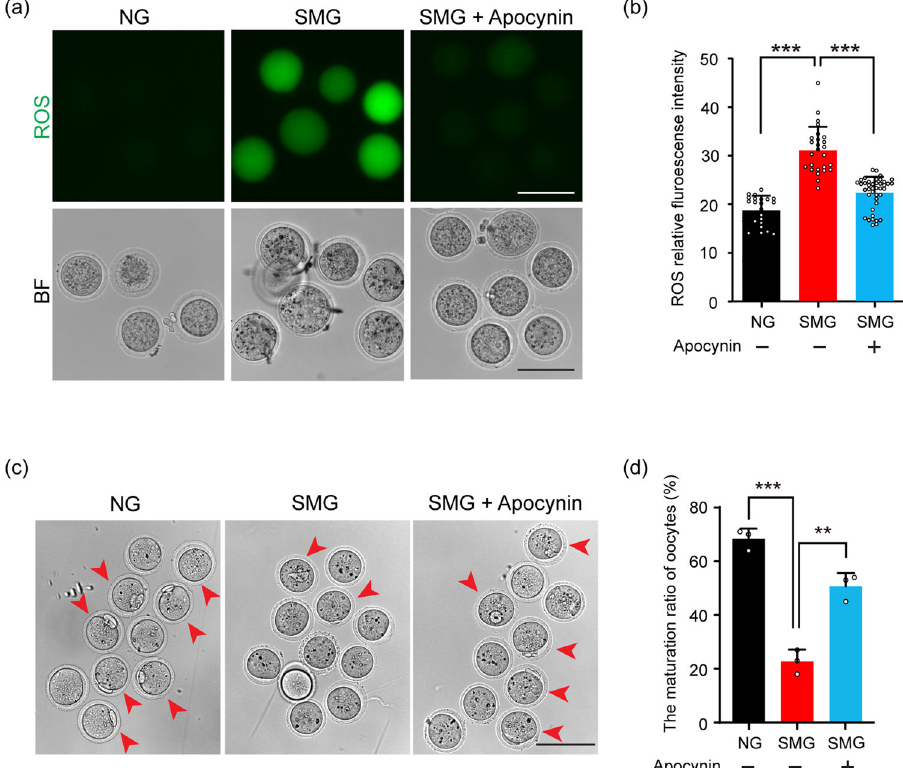
Fig. 6 Apocynin rescued SMG-related oocyte damage by decreasing the ROS level. a After follicle culturing with Apocynin under SMG condition, the follicle-released oocytes showed a dramatically decreased ROS level compared to the oocytes without Apocynin. Scale bars, 100 μ m. b The statistical analysis of DCF fl uorescence intensity, showing a decreased ROS level in oocytes of the Apocynin group ( n = 22 in NG, n = 26 in SMG and n = 41 in SMG + Apocynin). NG v.s. SMG: p value = 0.00000000000010, SMG v.s. SMG + Apocynin: p value = 0.000000028. c The ratio of PB1 (arrowheads) was markedly increased in the Apocynin-treated group compared to that in the SMG group. Scale bars, 100 μ m. d Statistic analysis showing a signi fi cantly increased ratio of PB1 in the SMG + Apocynin group compared to that in the SMG group ( n = 38 in NG, n = 35 in SMG and n = 43 in SMG + Apocynin). NG vs SMG: p value = 0.00021, SMG vs SMG + Apocynin: p value = 0.0019. Representative images of oocytes are shown. Data are presented as the mean ± SD. Data were analyzed by two-way ANOVA and n.s. P ≥ 0.05, ** P < 0.01, *** P <